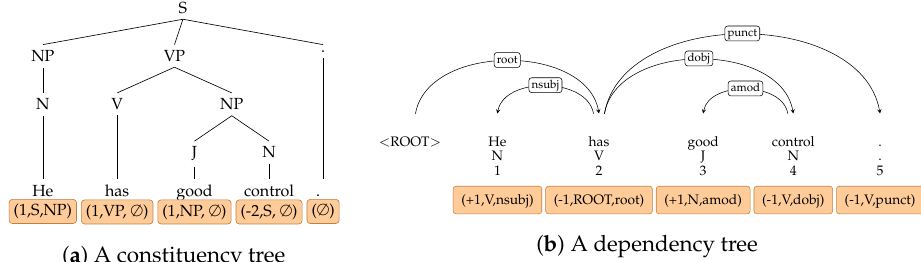
Figure 1. An example of syntactic trees for the same sentence represented under the constituency and dependency formalisms. Below, labels for each token encoding the trees.